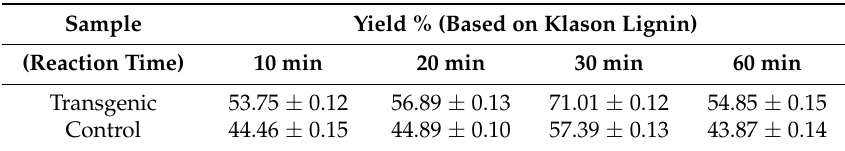
Table 1. Yields of lignocresols from transgenic and control lignin